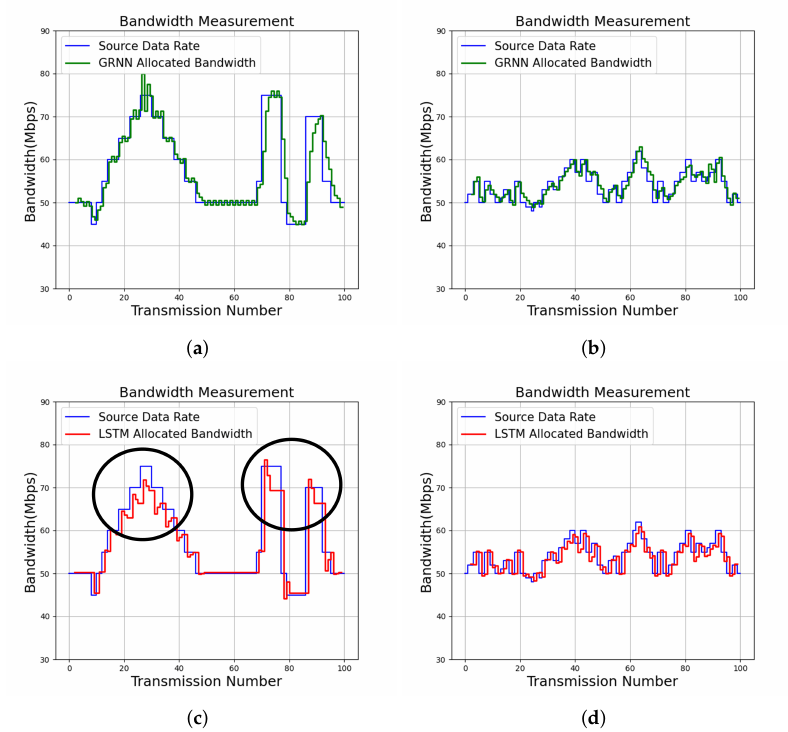
Figure 12. Bandwidth allocation results of the proposed algorithm with T = 6 and LSTM [16] for various services. Because LSTM may not be self-aware, parts of bandwidth allocation results where self-awareness are not attained are marked. ( a ) Proposed GRNN for Service 1; ( b ) Proposed GRNN for Service 2; ( c ) LSTM for Service 1; ( d ) LSTM for Service